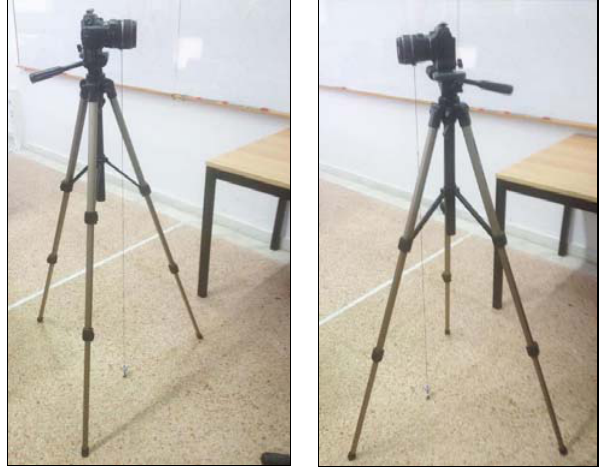
Figure 10. Image acquisition; keeping constant the same ground point at each shoot.